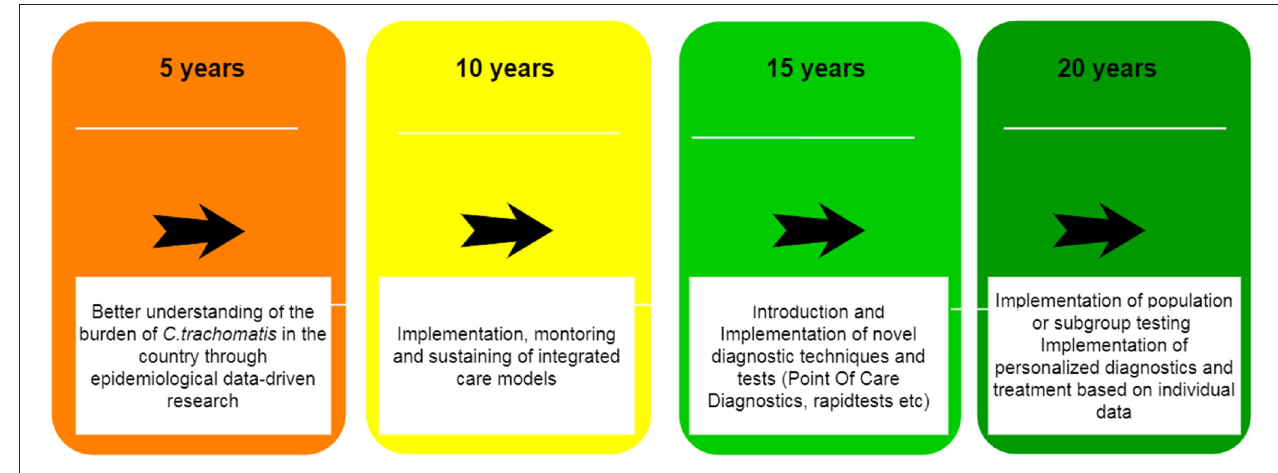
FIGURE 4 | A roadmap to improve Chlamydia trachomatis management and control in India over the next 20